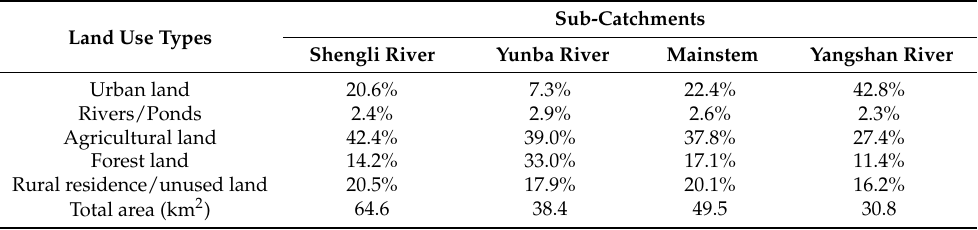
Table 1. Different land-use types in of Yuntaishan River